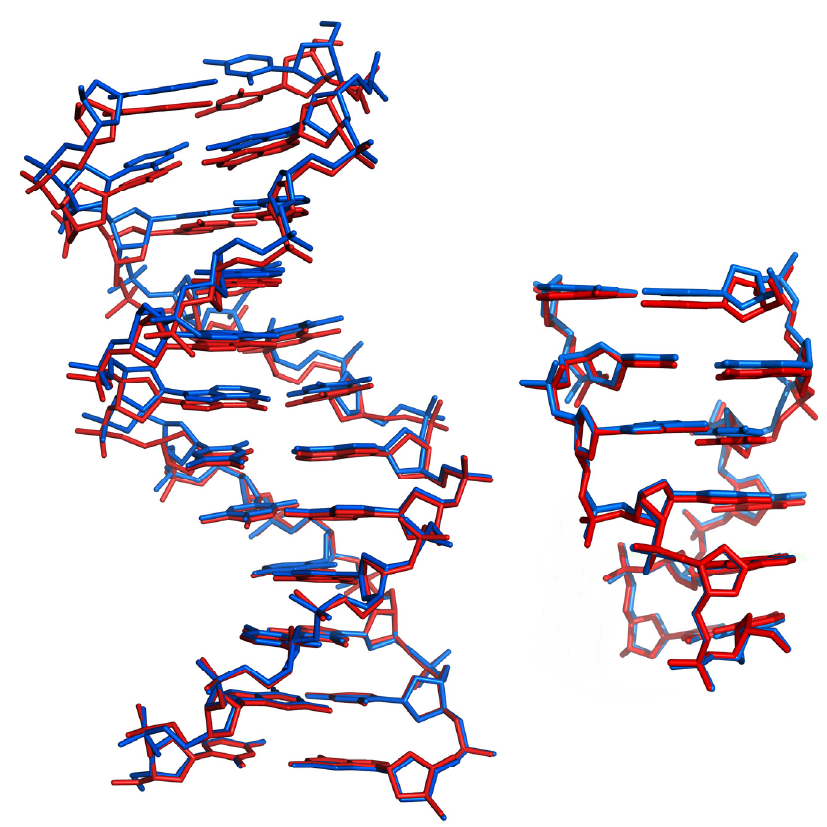
Figure 6. Superposition of the B-DNA ( left ) and Z-DNA ( right ) structures at ambient pressure (in blue) and 310 MPa and 715 Mpa, respectively (in red), showing, in both cases, the amplitude of the base